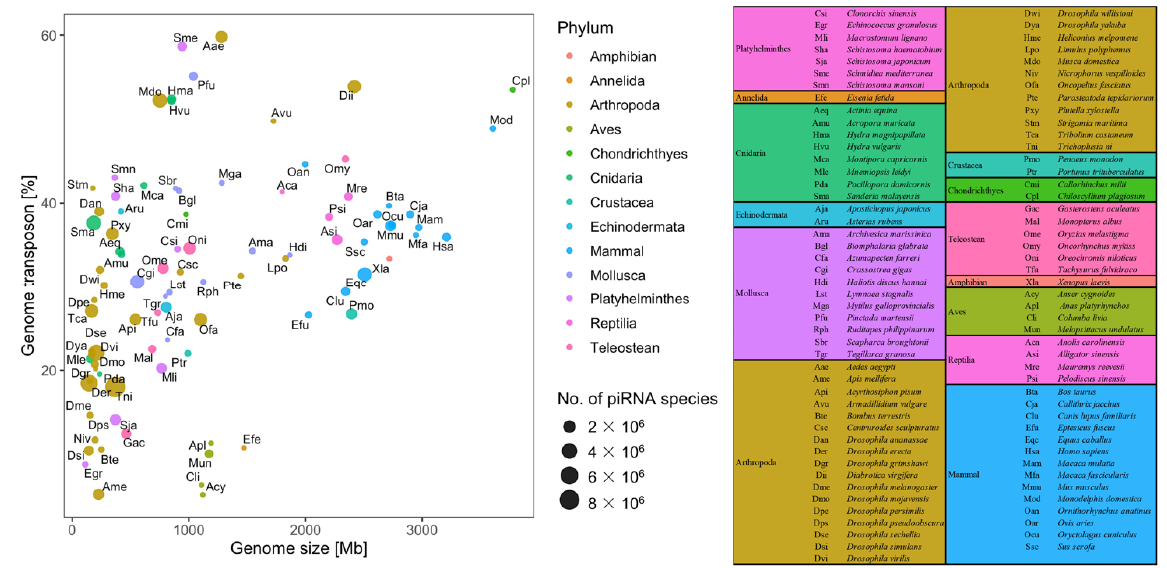
Figure 2. Discovery of piRNAs in metazoans. In the same taxa, the proportion of TEs increases with the genome size, whereas the number of piRNA species does not increase with the size of the genome or the proportion of TEs. Table 1. Discovery of piRNAs by sRNA-seq in metazoans.